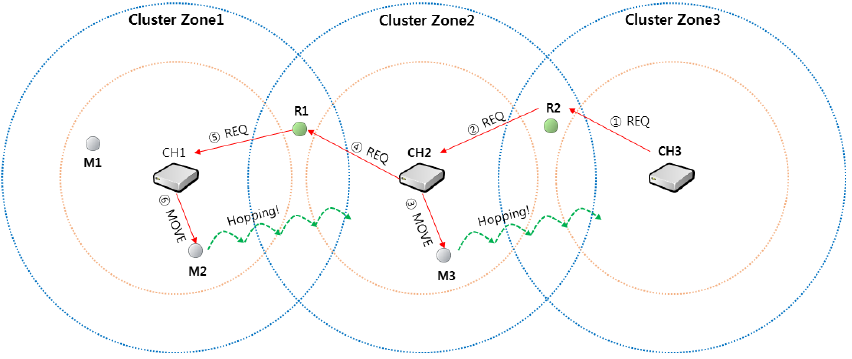
Figure 6. An example of recovering sensing holes through relay relocation strategy.